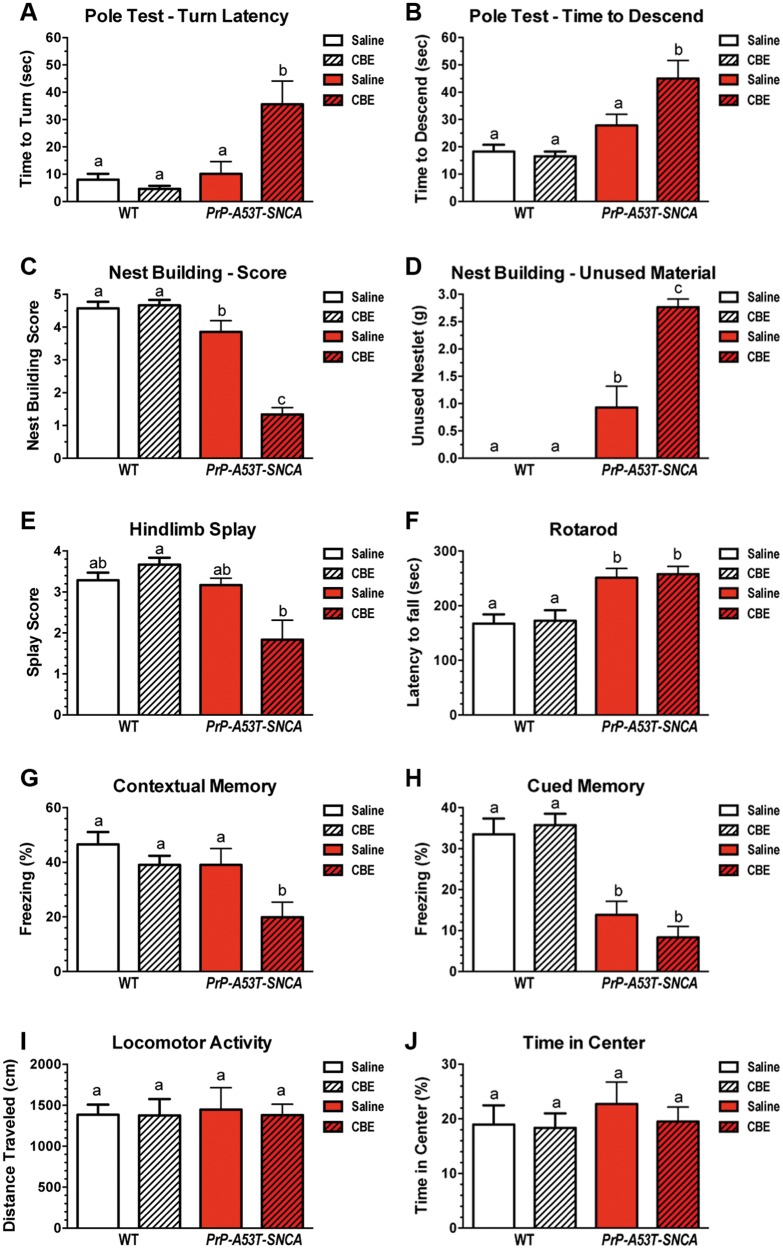
Reducing glucocerebrosidase activity in the CNS of A53T-α-synuclein mice exacerbates motor and cognitive deficiencies. Two-month-old WT (white bars, n = 10 per group) and PrP-A53T-SNCA (red bars, n = 12 per group) mice were injected three times per week with saline (solid bars) or 100 mg/kg CBE (hatched bars) for 10 weeks. Fine motor skills were assessed using the pole (A, B), nest-building (C, D), and hindlimb splay (E) tests. Treatment of WT mice with CBE had no effect on the results of any of these behavioral assessments when compared with the saline-treated controls. Saline-treated PrP-A53T-SNCA mice showed a mild deficit in nest-building scores compared to WT mice (C). This finding is corroborated by the finding that the control PrP-A53T-SNCA animals had a greater amount of unused nestlet material (D, solid red bar). Glucocerebrosidase inhibition caused a marked deterioration in fine motor skills after 8 weeks of treatment with CBE. CBE-treated PrP-A53T-SNCA mice displayed significantly longer turn and descent latencies than any of the other cohorts (A-B, red hatched bar, p < 0.05). CBE treatment also worsened the nest-building scores of PrP-A53T-SNCA mice (C, red hatched bar, p < 0.05). This result was corroborated by the finding of large amounts of unused nestlet material with this group of animals (D, red hatched bar, p < 0.05). CBE treatment caused a hind-limb splay deficit in PrP-A53T-SNCA mice (E, red hatched bar, p < 0.05). PrP-A53T-SNCA mice displayed improved rotarod latencies compared with WT controls (F, white versus red bars, p < 0.01). The ability of either WT or PrP-A53T-SNCA mice to remain on the rotating rod was unaffected by CBE-mediated inhibition of glucocerebrosidase (F, hatched bars, p > 0.05). The cognitive status of WT and PrP-A53T-SNCA mice was evaluated by monitoring their conditioned fear responses. PrP-A53T-SNCA mice showed no contextual memory deficits at 4 months of age when compared with age-matched WT mice. However, their hippocampal memory was affected upon treatment with CBE (G, red hatched bar, p < 0.05), suggesting an association between hydrolase activity and hippocampal memory. PrP-A53T-SNCA mice displayed impaired cued memory responses at 4 months of age that were not further exacerbated by glucocerebrosidase inhibition (H). In open-field tests, there were no differences in ambulation or time spent in the center between PrP-A53T-SNCA and age-matched WT controls (I, J). All data are presented as the mean ± SEM. Bars with different letters are significantly different from each other (p < 0.05).